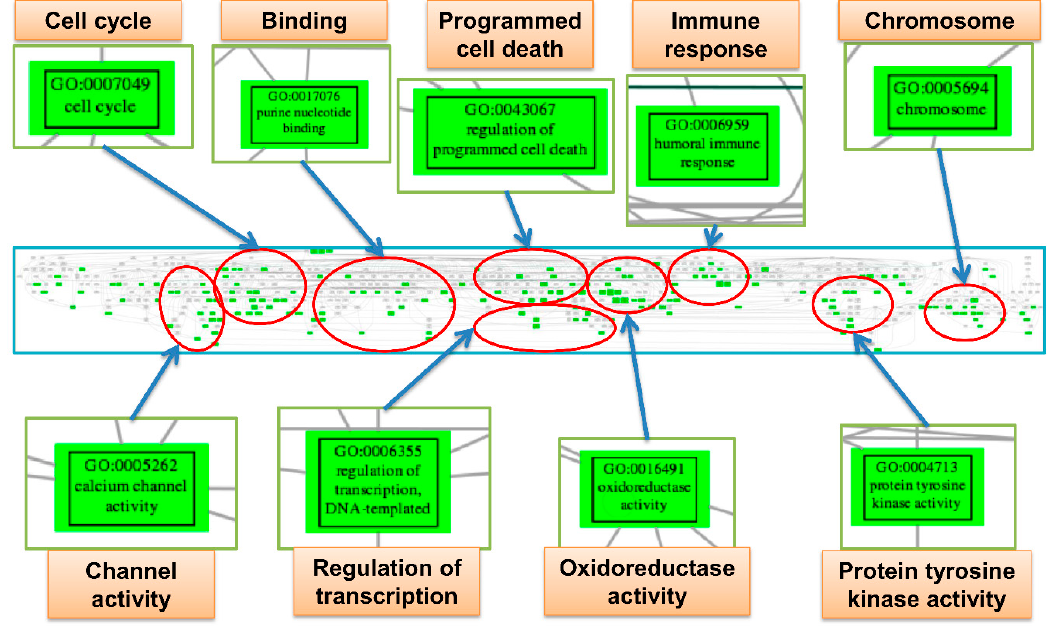
Figure 6. The gene ontology tree of serous carcinoma. This figure displayed a screenshot of the full gene ontology (GO) tree for serous carcinoma (SC) ( middle ). After mapping to the GO tree, the similar or related GO terms were clustered together. Each cluster was circled ( red ), and the important deregulated GO terms ( green boxes ) in the cluster were magnified to view the details. Each cluster was labeled by the common parental GO term ( orange rectangle ).